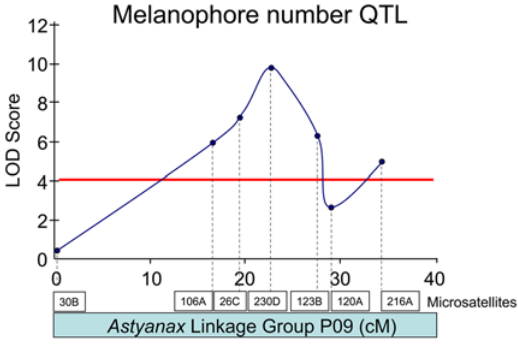
Figure 5. A melanophore number QTL resides on Astyanax linkage group P09. The genetic architecture of the melanophore number trait in our cross yields a single strong QTL consistent with the predictions of breeding experiments, as previously described [18]. The x-axis depicts the relative positions of microsatellite markers on linkage group P09, LOD score values (y-axis) across markers are depicted in dark blue. A LOD score significance value of 4.0 is depicted by a horizontal red line.